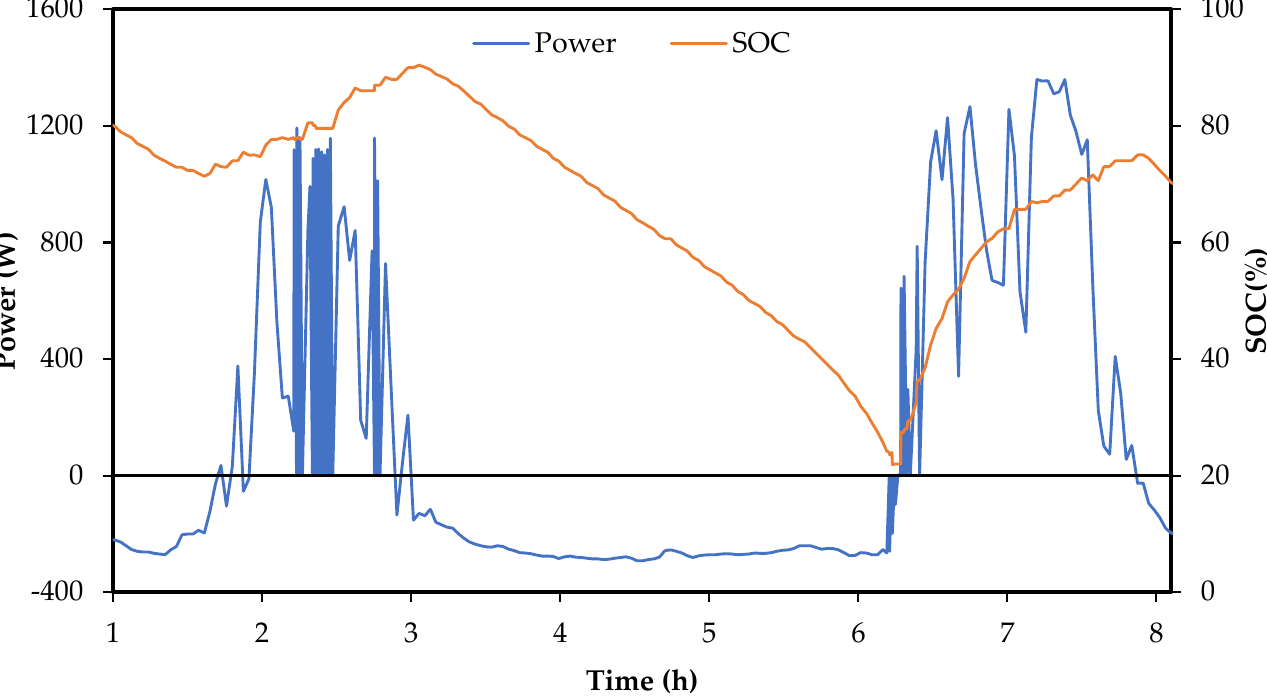
Figure 6. Battery performance with 40 L electrolyte with SoC variation for S P = 1 and S T = 1/5.